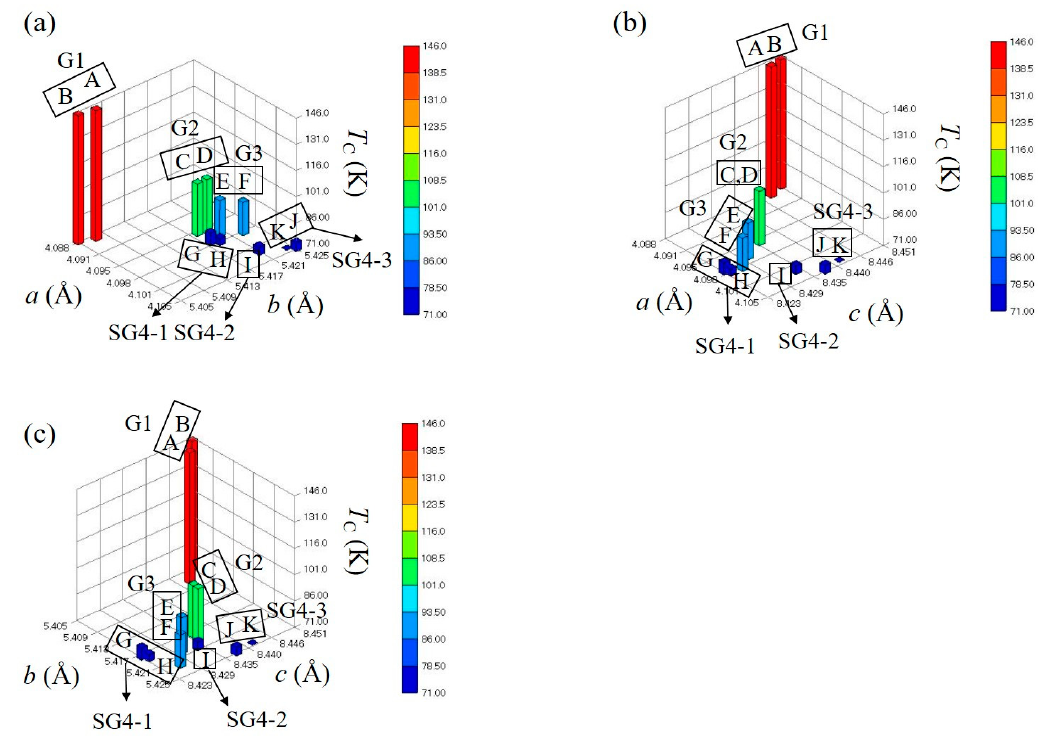
Figure 9. 3D bar graphs of T C as a function of ( a ) a and b , ( b ) a and c , and ( c ) b and c , respectively.